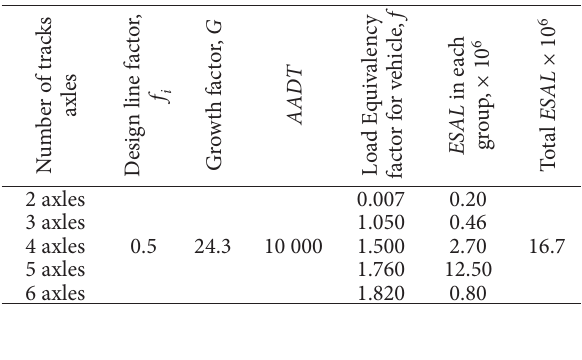
Table 7. Total ESAL estimation parameters